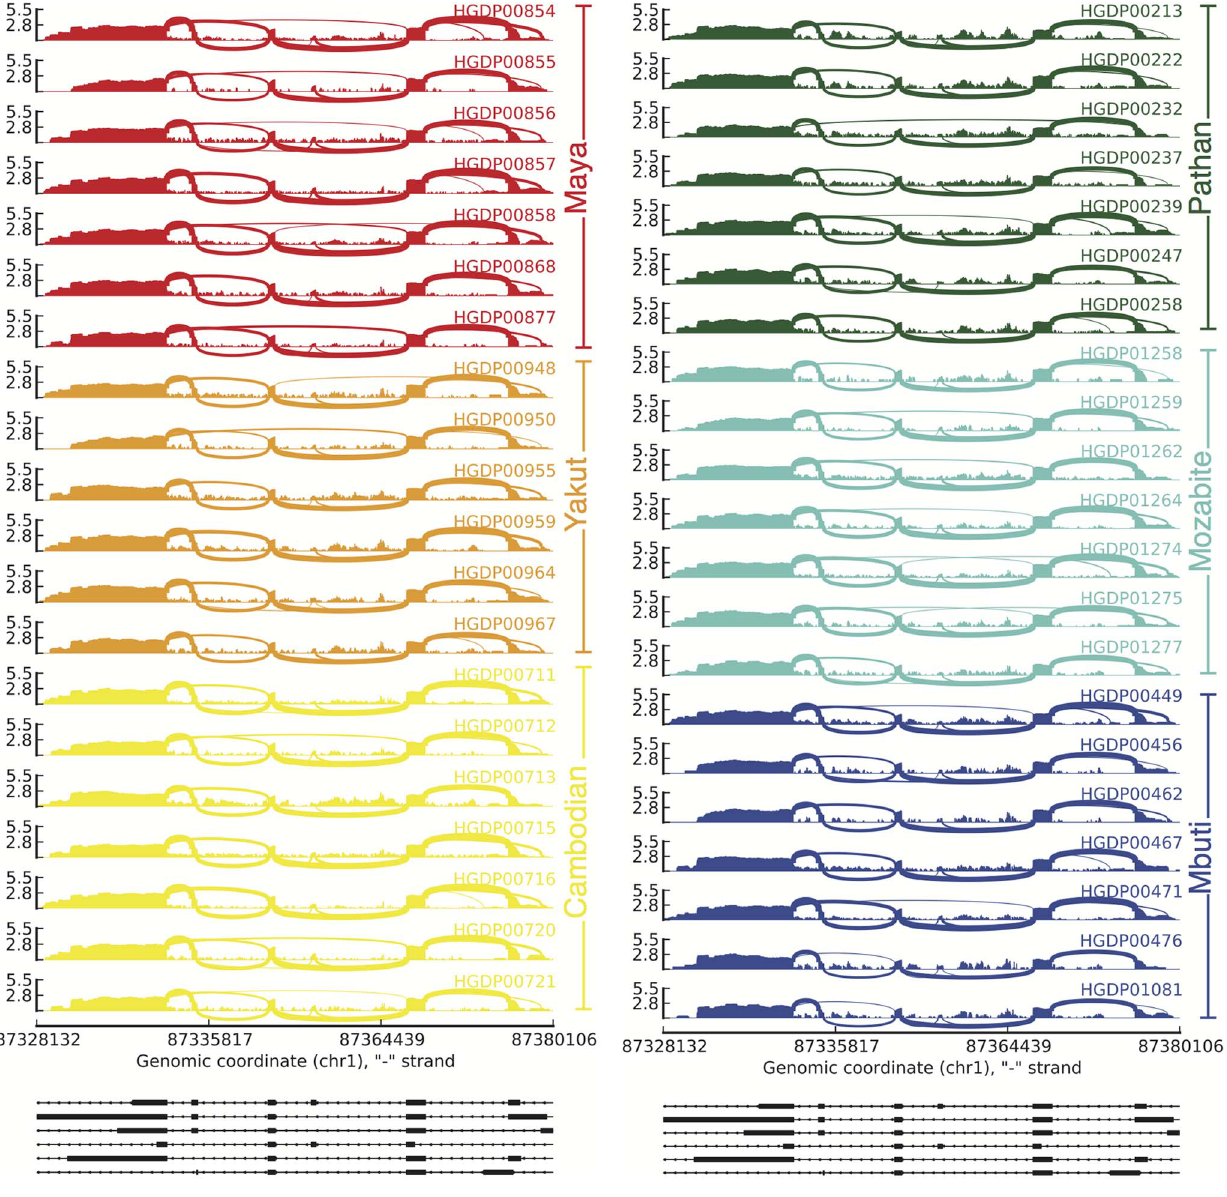
Figure 6. Splicing variability across human populations. Each sashimi plot shows the expression within an individual for a differentially spliced gene (ENSG00000183291.11, SEP15). The RNA-seq read densities supporting expression over the region as well as the inclusion and exclusion of exons are shown and line densities are proportional to reads supporting splicing events. The y-axis on each sashimi plot indicates the expression in log 10 reads per kilobase per million reads (log 10 (RPKM)). The plots on the bottom show the transcript structure within the gene.